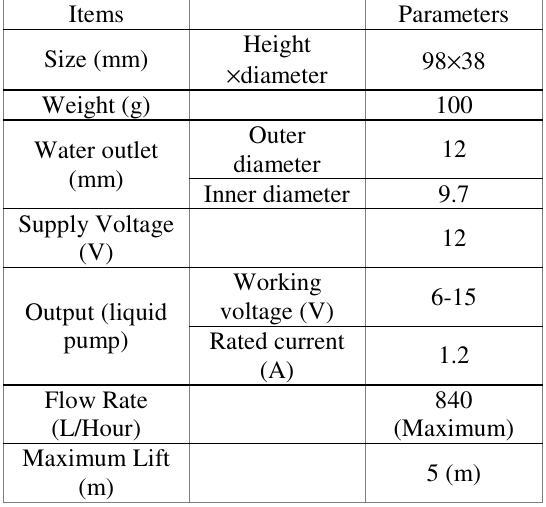
FIG. 5: INTEGRATED UAV SYSTEM WITH SPRAYING MECHANISM TABLE 1: PARAMETER OF SPRAYING CONTROLLING